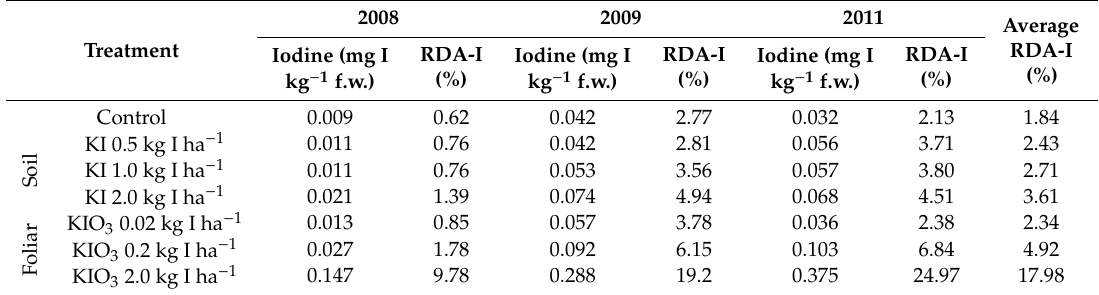
Table 8. Percentage coverage of Recommended Daily Allowance for iodine (% RDA-I) by 100 g of fresh potato tubers in individual years of the study.